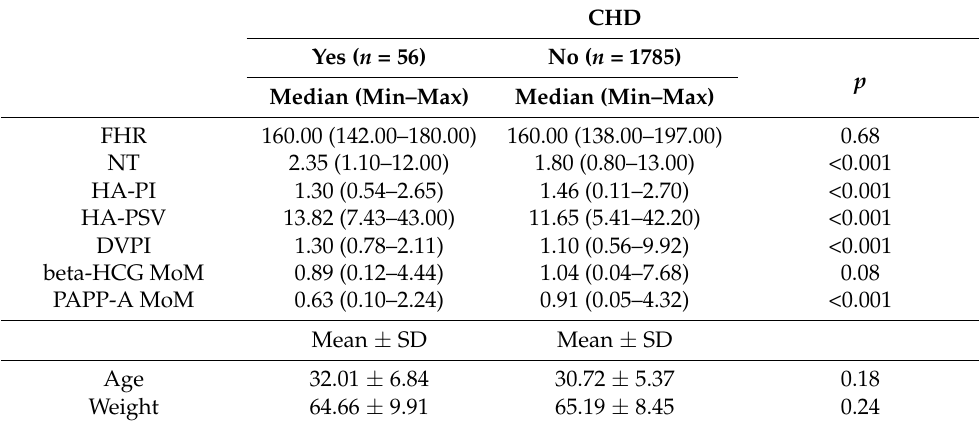
Table 6. Differences between selected first-trimester screening parameters depending on present or absent fetal CHD diagnosis.